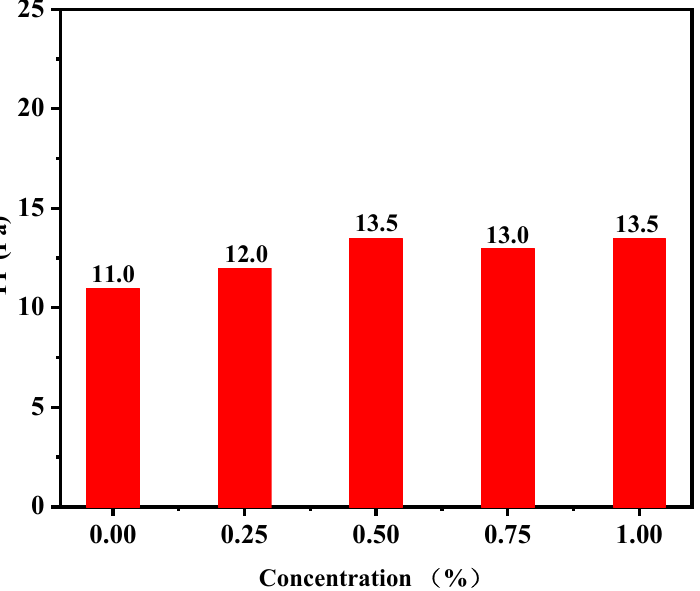
Figure 6. YP change curve after aging of oil-based drilling fluids with the addition of poly (MMA-BA-ST).